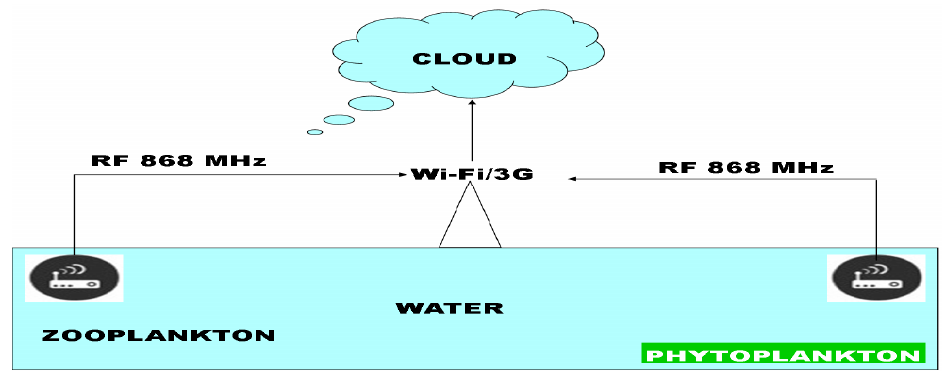
Figure 6. Aquarium of Zaragoza Solution Diagram [56]. RF: Radio Frequency.